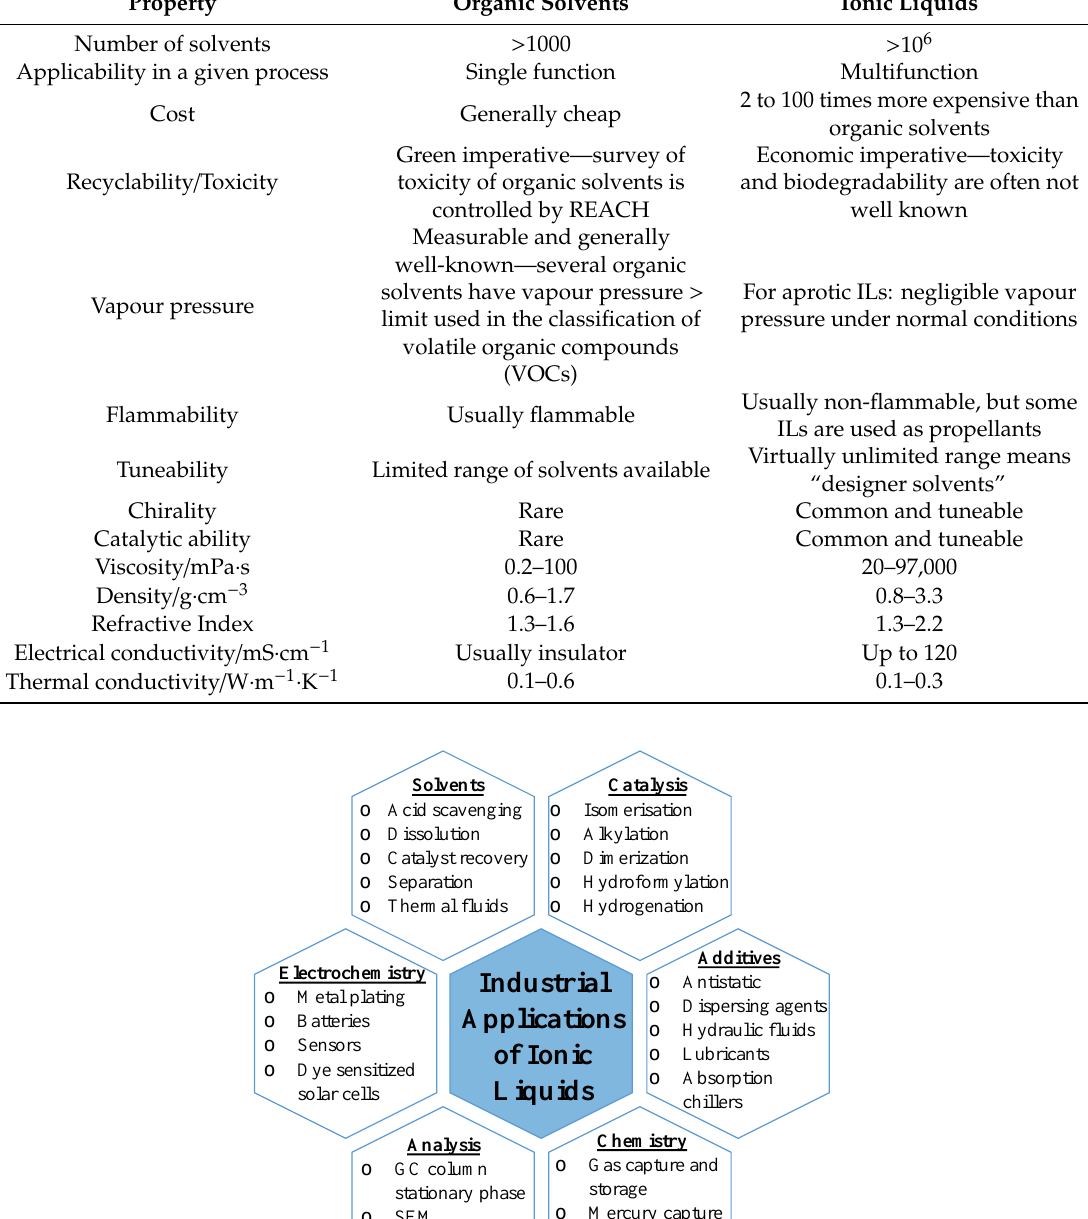
Table 1. Comparison of organic solvents with ionic liquids (ILs), updated from work by Plechkova and Seddon [19]. Range of values were analysed from the NIST ILThermo database at 25 ◦ C and atmospheric pressure [22,23].